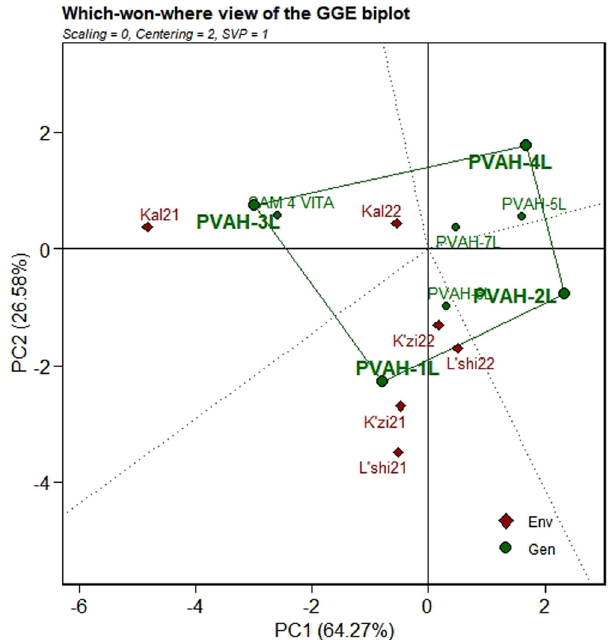
Figure 2: Polygon view of genotype and genotype × environment interaction biplot of grain yield for eight provitamin A maize genotypes evaluated in six test